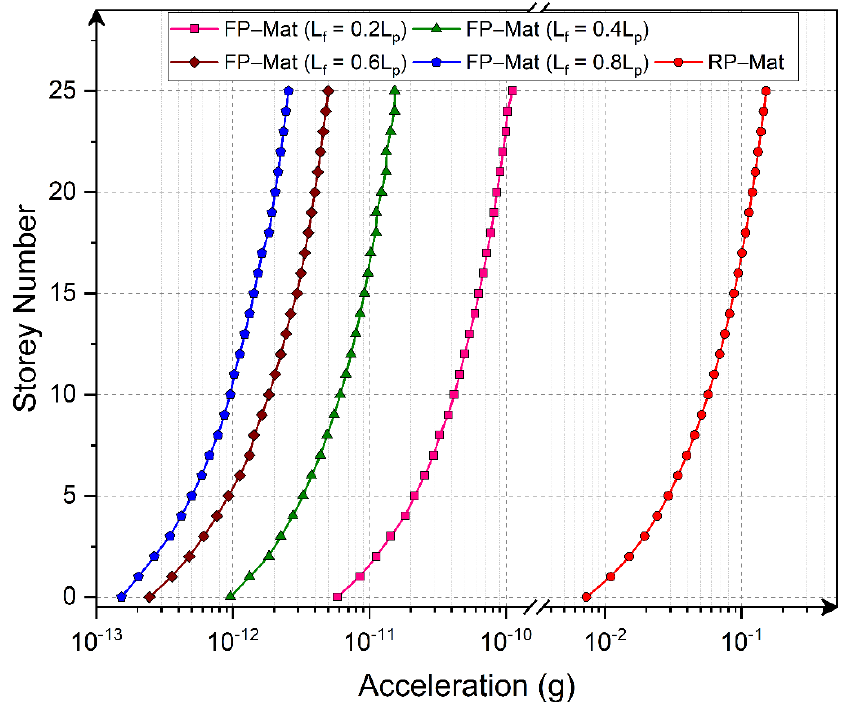
Figure 12. Variation in peak accelerations, at all floor levels, of the high-rise buildings that are sup- ported by FP-Mats of varying